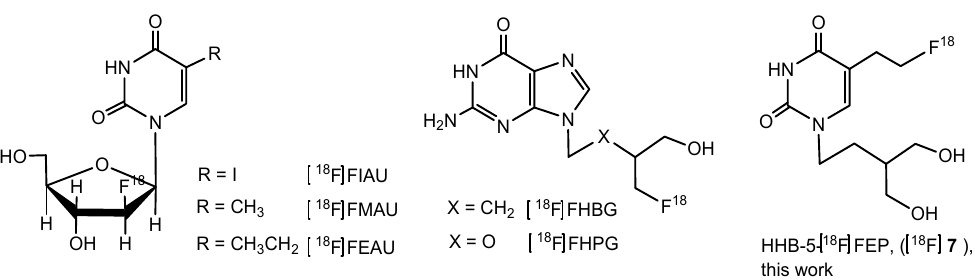
Figure 1. Structures of some pyrimidine and purine nucleoside analogues and HHB-5-[ 18